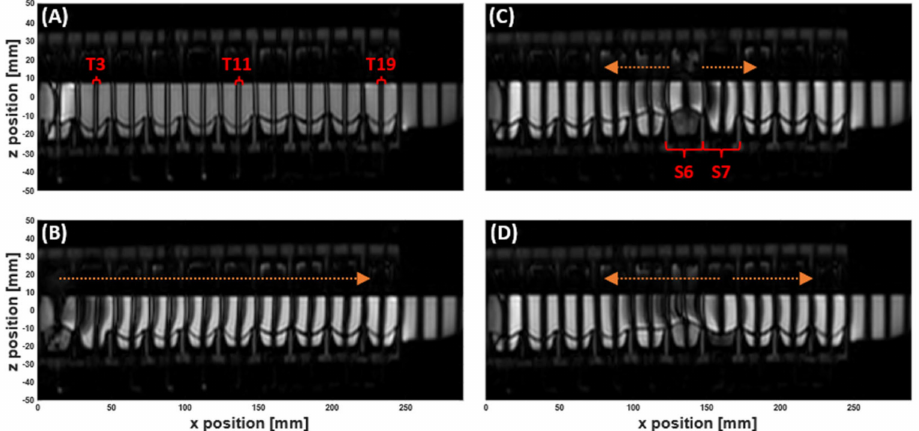
Figure 2. MR Tagging applied to the dynamic colon model (DCM) filled with 200 mL LOVIS fluid. ‘Tags’ are the dark stripes across the images. The DCM is orientated such that the caecum is at x = 0 mm, and the hepatic flexure begins at x = 250 mm. ( A ) Coronal image showing no movement inside the DCM before motility is initiated. The tags are straight, parallel and intact. ( B ) Tagged image during contraction of the first DCM segment. Tags are shifted in the positive x -direction showing a wave of antegrade flow travelling through the lumen. ( C ) and ( D ) Tagged images of the DCM during contraction of segment 6, showing antegrade flow in the immediately downstream tag at early stages of contraction ( C ) and stronger retrograde flow in all adjacent tags ( D ). The arrows drawn onto the images are to aid visualisation of the direction of tag displacement and therefore motion of the contents. Tags (T) 3, 11 and 19, and segments (S) 6 and 7 are labelled as these were the focus of velocimetry studies in Sections 3.2 and